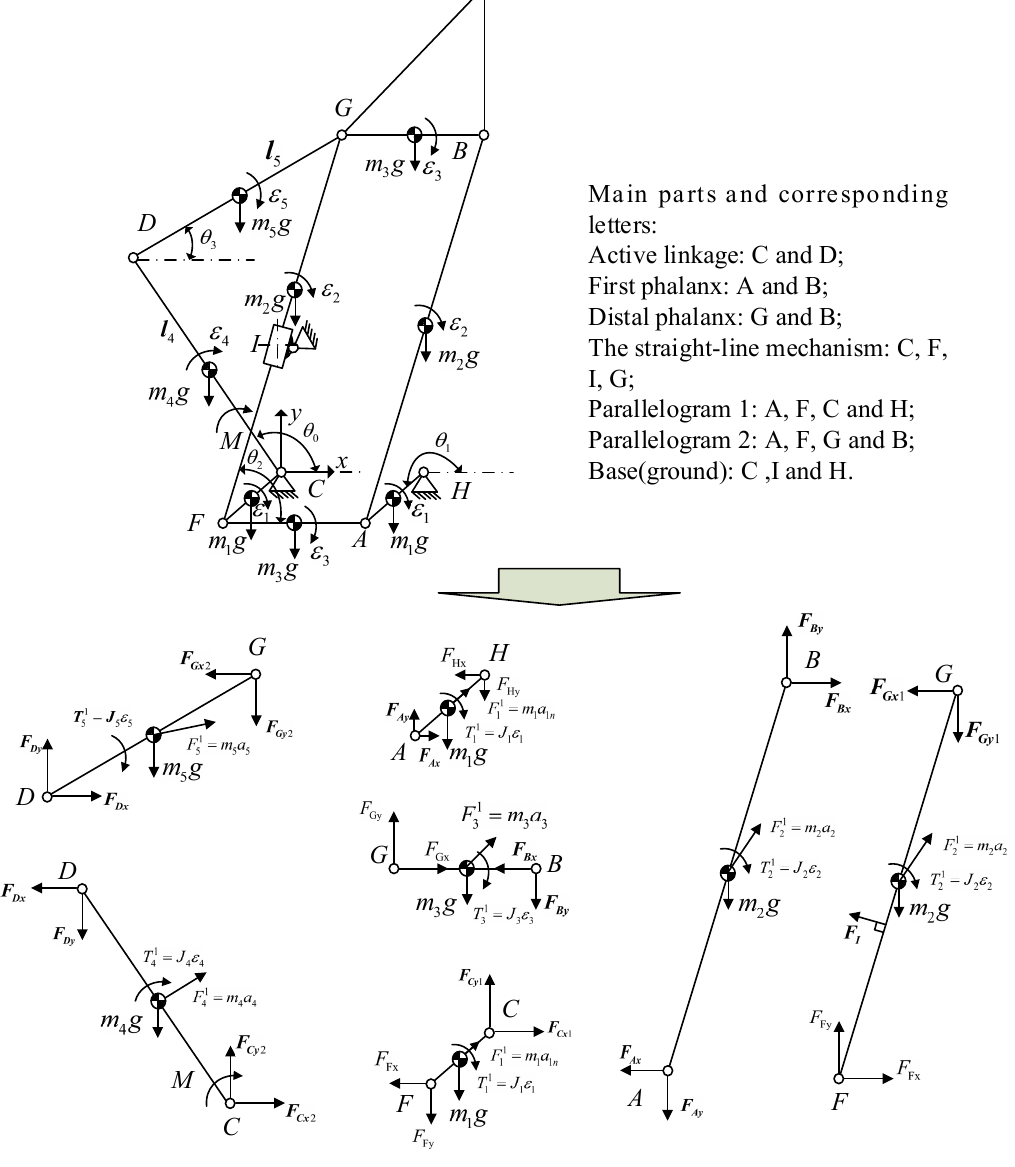
Figure 7. Equitant dynamics model of the finger mechanism.